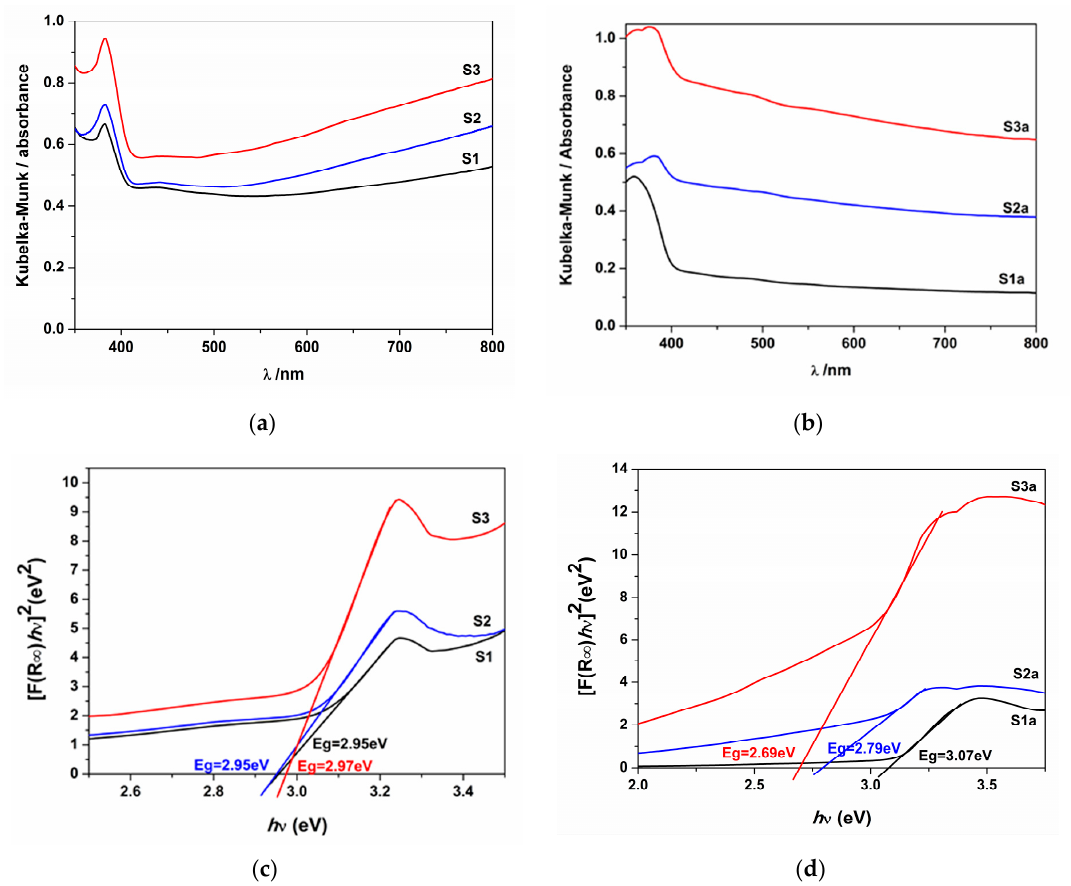
Figure 6. UV-Vis absorption spectra of the Ti-TiO 2 layers ( a ) and Ti-TiO 2 -CuMnO 2 ( b ) heterostructures; The α h υ versus Eg curve for the Ti-TiO 2 ( c ) and the Ti-TiO 2 -CuMnO 2 ( d ).